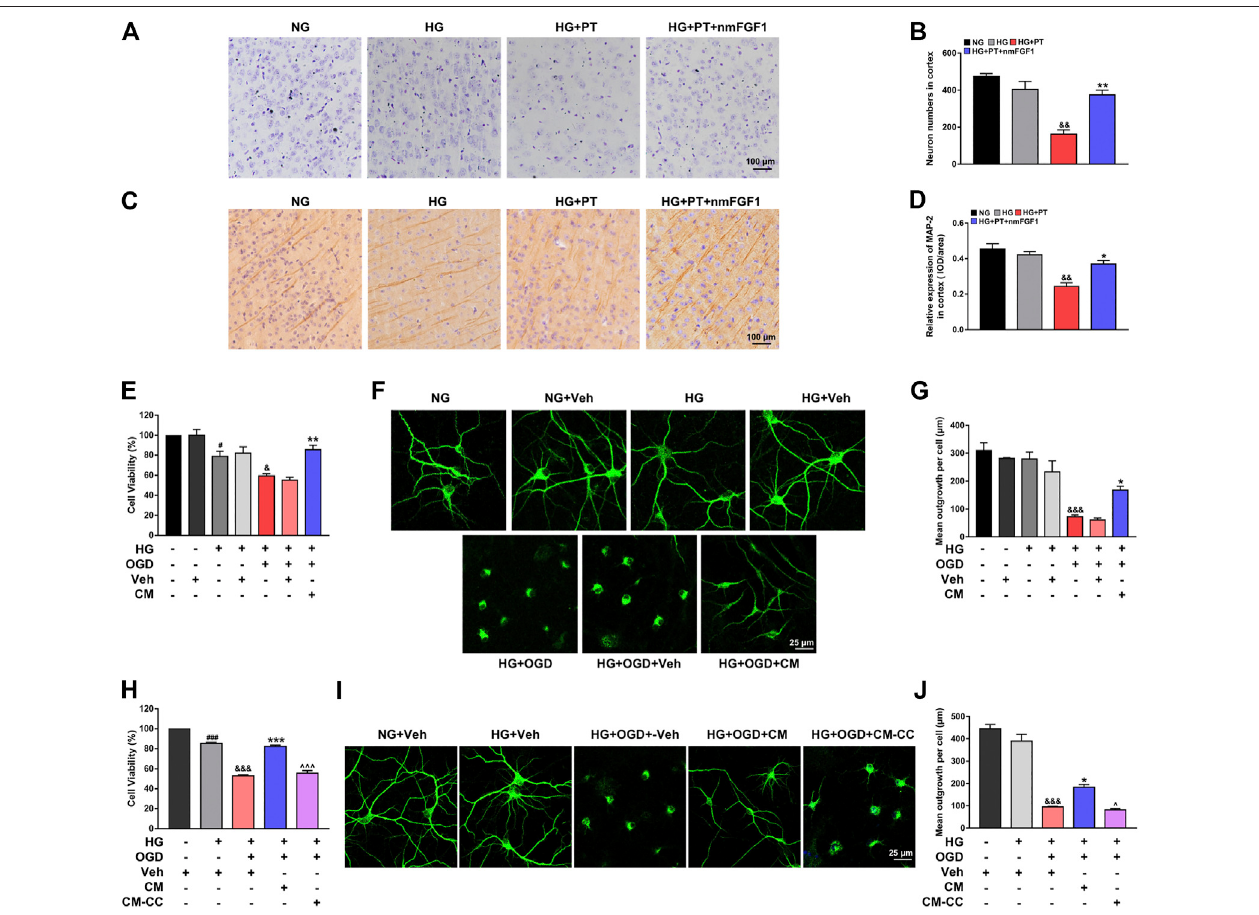
FIGURE6| NmFGF1amelioratedneuronallossinamousemodelofdiabeticstroke via AMPK-mediatedangiogenesis. (A) RepresentativeimagesofNisslstaining in the ipsilateral cortex region on day 7 after ischemic stroke. (B) The number of neurons in the cortex sub fi eld were statistically analyzed with Image-Pro Plus software. (C) Representative images of immunohistochemical staining MAP-2on day 7after ischemic stroke. (D) Quantitative analysis of MAP-2 expression. Scale bar (cid:2) 100 μ m. (E) Effect of endothelial conditioned medium on the viability of HG + OGD-treated neurons. (F, G) Representative images of MAP2 immuno fl uorescence staining and quantitative analysis. (H) The effect of compound C treated endothelial conditioned medium on the viability of HG + OGD-treated neurons. (I, J) Representative images of MAP2 immuno fl uorescence staining and quantitative analysis. Scale bar (cid:2) 25 μ m. Conditioned medium from replacement medium after HG + OGD-cultured HBMECs treatment withor withoutnmFGF1for24 h, theformer referred toasCMand thelatter asVeh.Inaddition, theconditioned medium fromcompound C-treated HBMEC cells cultured in CM, we referred to as CM-CC. Data are presented as means ± SEM (n (cid:2) 3). # p < 0.05, ## p < 0.01 vs. NG or NG + Veh group; & p < 0.05, && p < 0.01, &&& p < 0.001 vs. HG or HG + Veh group; * p < 0.05, ** p < 0.01, *** p < 0.001 vs. HG + OGD or HG + OGD + Veh group. ^ p < 0.05, ^^^ p < 0.001 vs. HG + OGD + CM